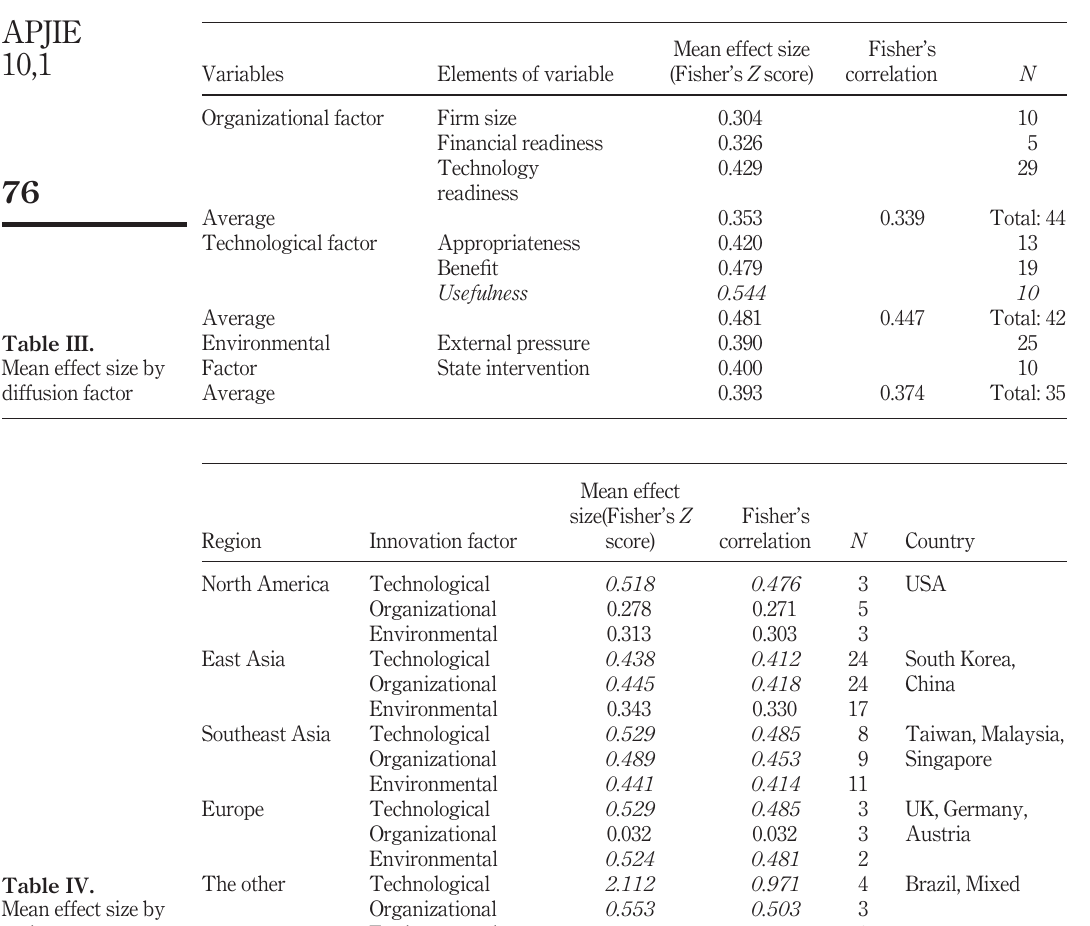
Table IV. Mean effect size by region